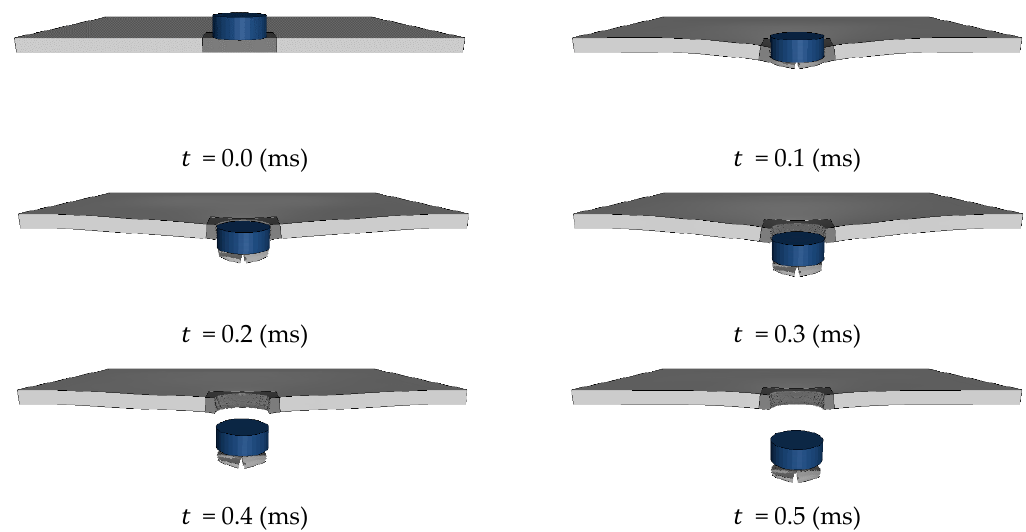
Figure 6. Impact response of a 10 mm thick aluminum plate by a projectile with an initial velocity of 200.9 m/s with the element size of 0.63 mm.